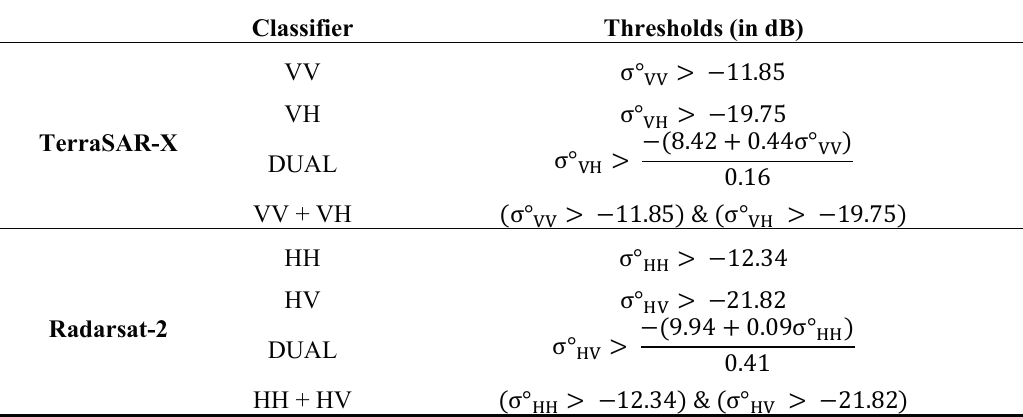
Table 4. Pixel thresholds to qualify as shellfish for the different classifiers for TerraSAR-X and